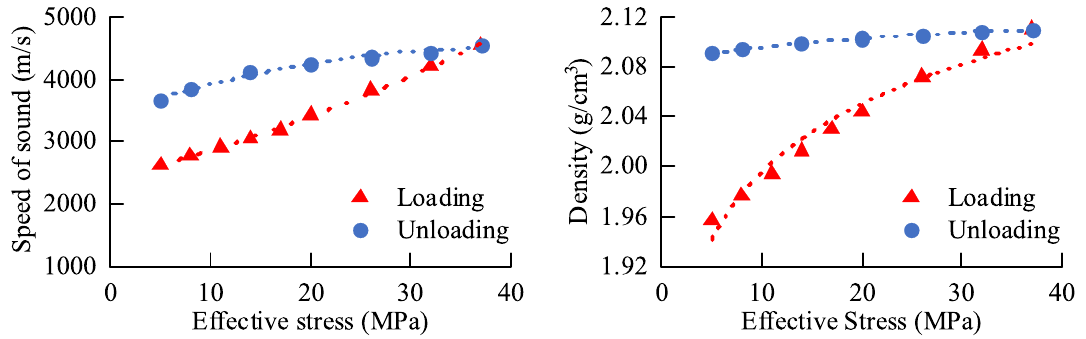
Figure 1. Relationship between sound wave velocity or density and effective